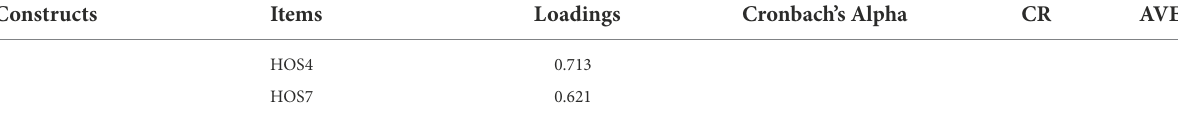
TABLE 3 Discriminant validity (HTMT)